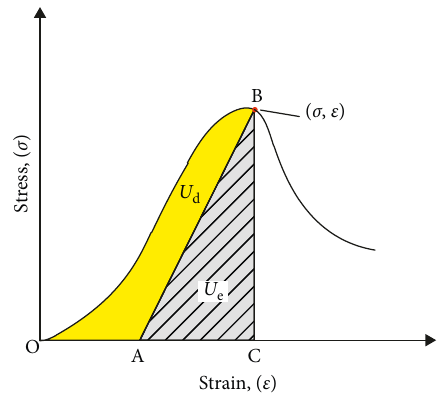
Figure 10: Schematic of the energy components during UCS